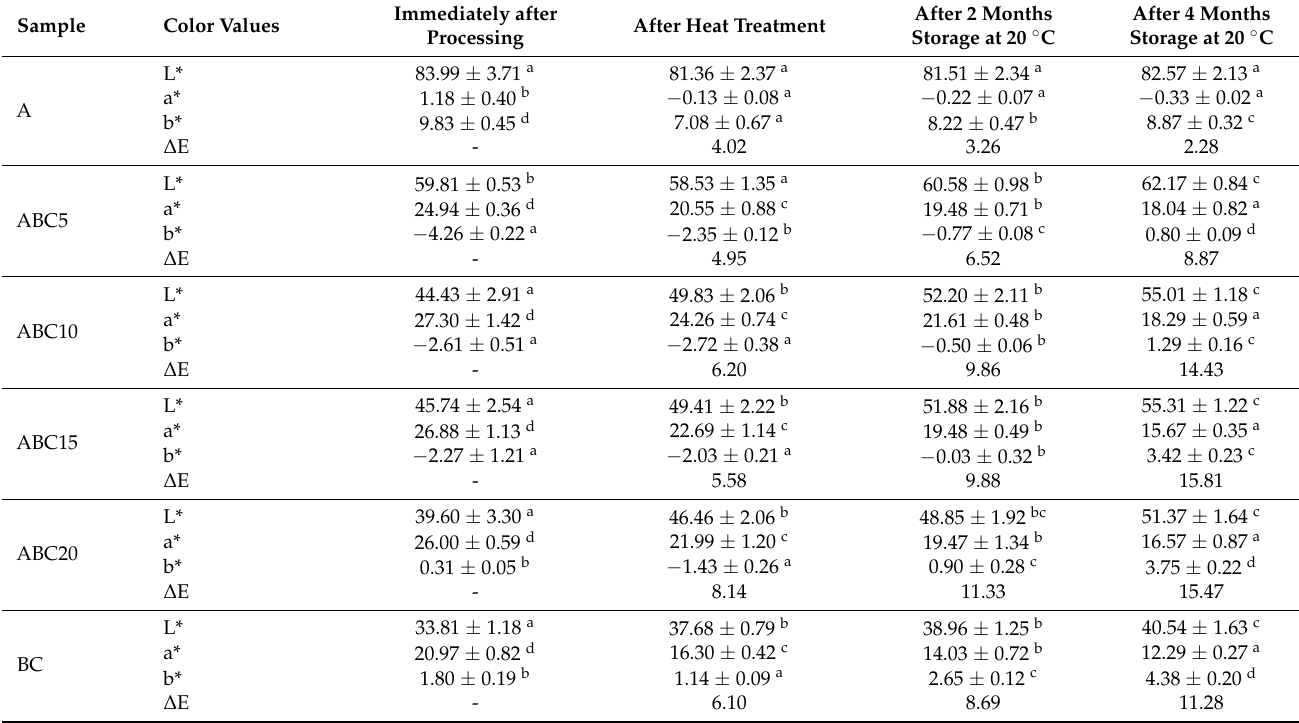
Table 3. Color parameters of the tested juices immediately after processing, after the heat treatment, and after four months of storage *.